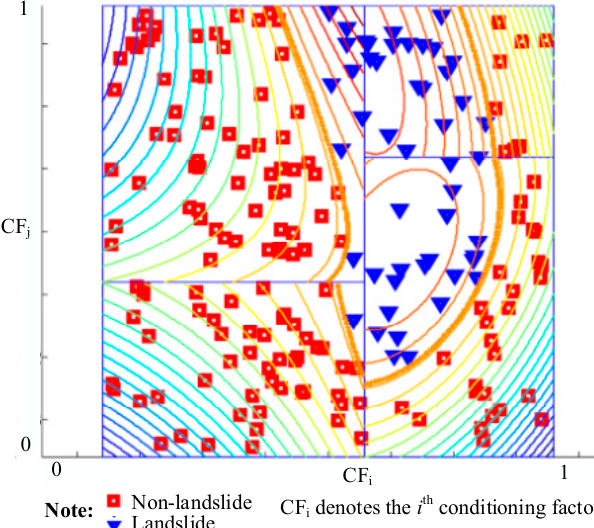
Figure 8. Illustration of using the SVM and the resulting smooth borders (bold curves).